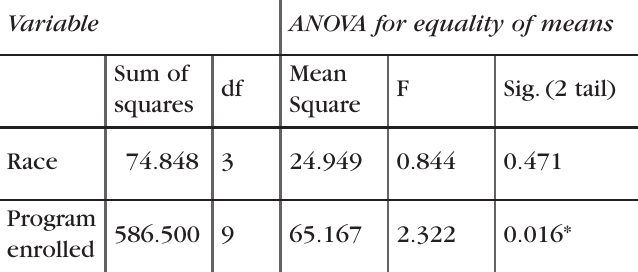
Table 5. ANOVA for Race and Programs Enrolled